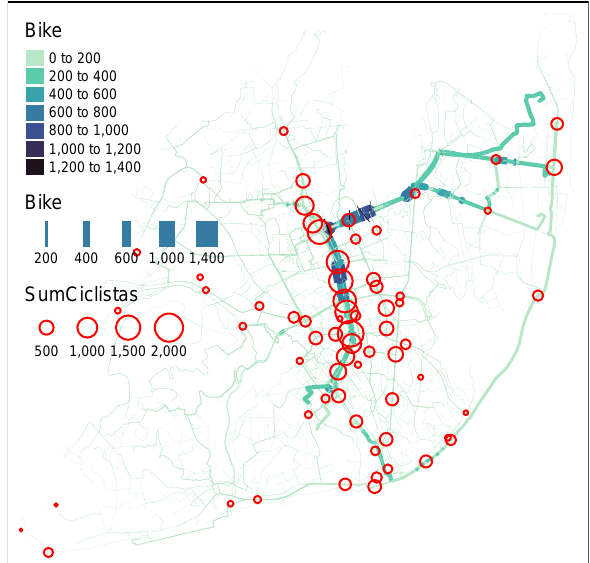
Figure 8. Route network from jittered desire lines with disagregation of 500 trips, with routes from Google.